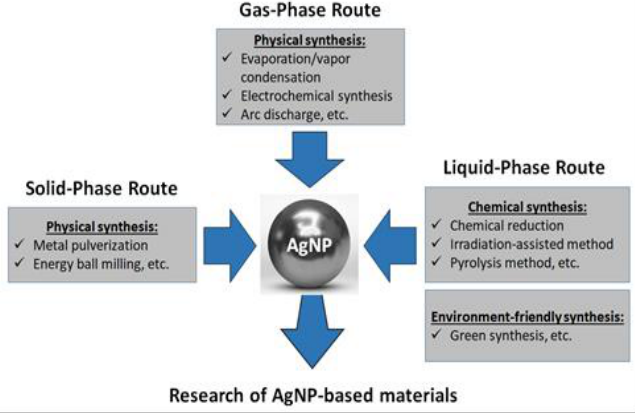
Fig. 1. Different routes of silver nanoparticles (AgNP) synthesis. Adopted from literature